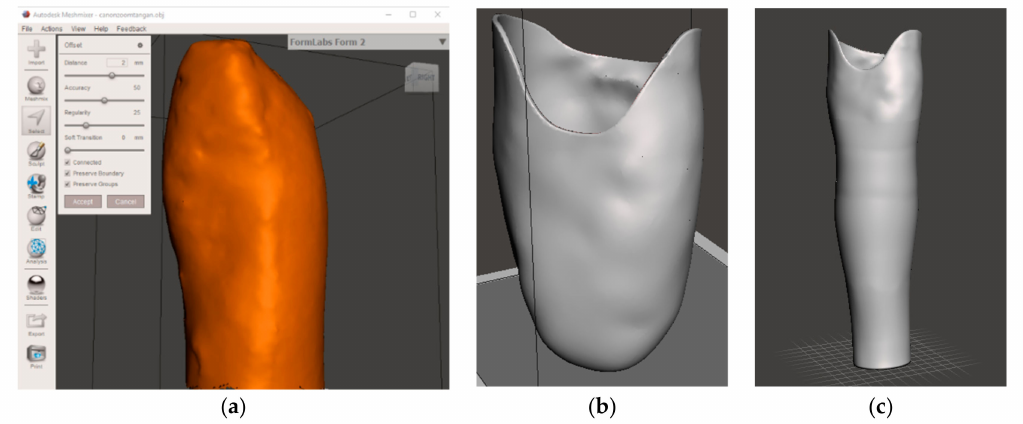
Figure 4. ( a ) Imported 3D stump model, ( b ) rectification result, and ( c ) final 3D model of the stump processed in Autodesk